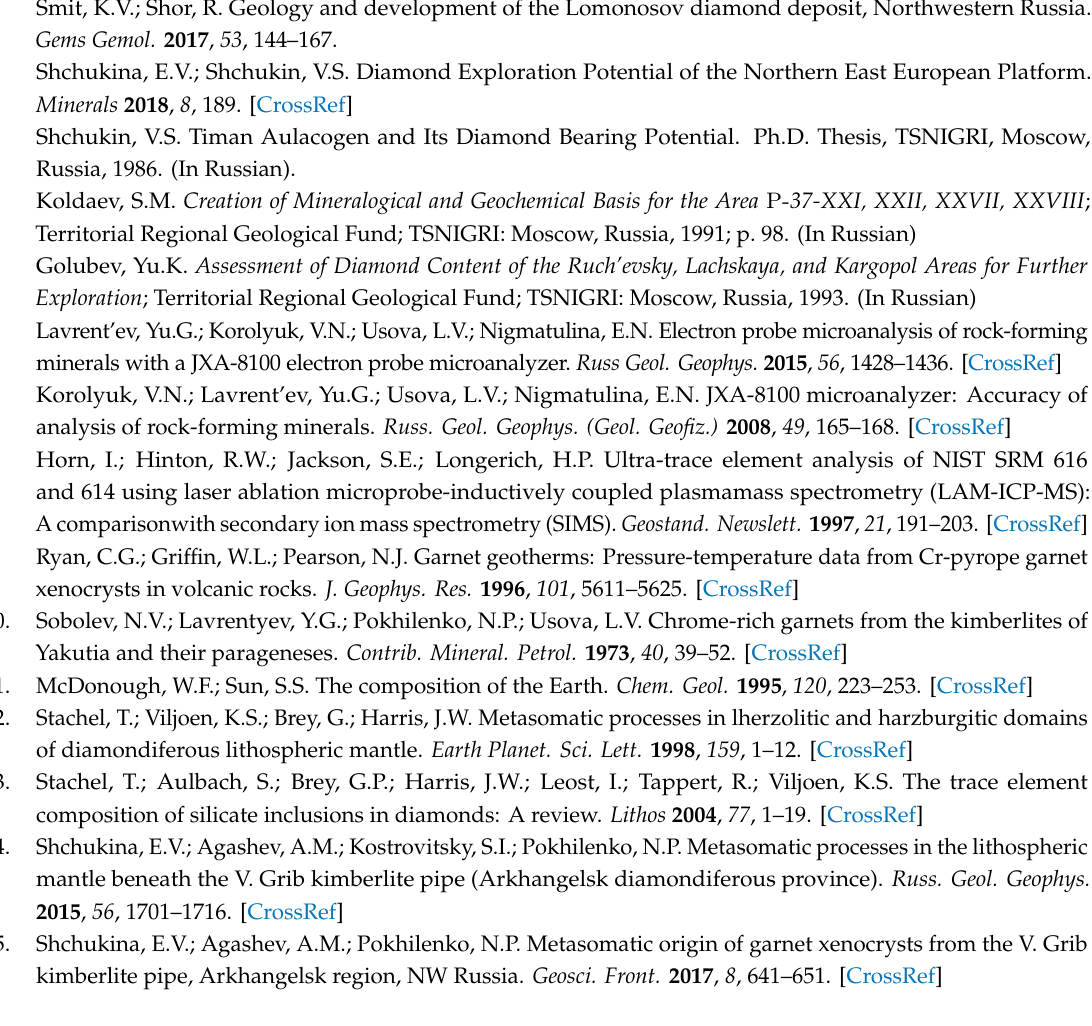
Table S1: Major (wt.%) and trace (ppm) element composition of garnet and estimated temperature ( ◦